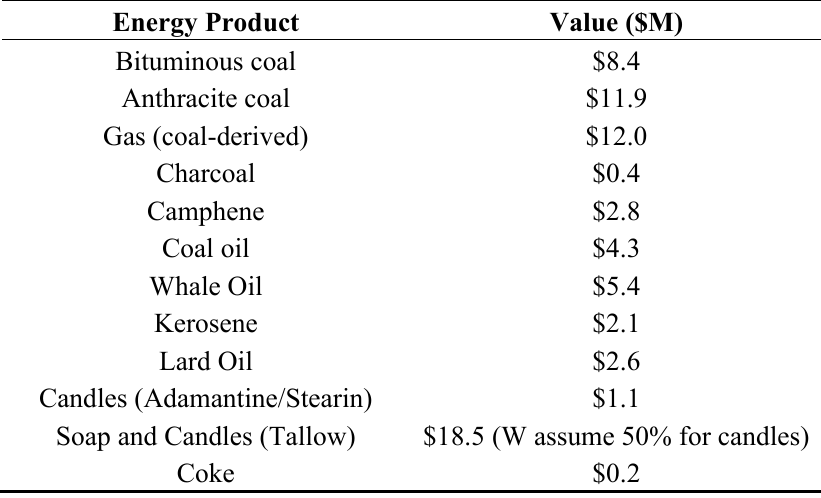
Table 3. Commercial energy production in the United States census, 1860. Source: